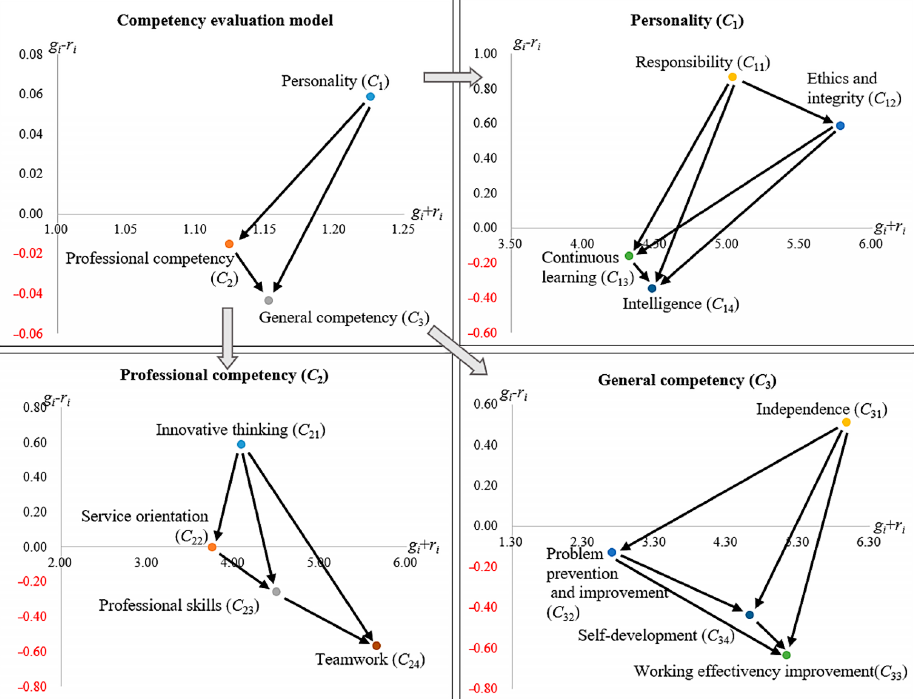
Figure 3. Influential significance-network relation map